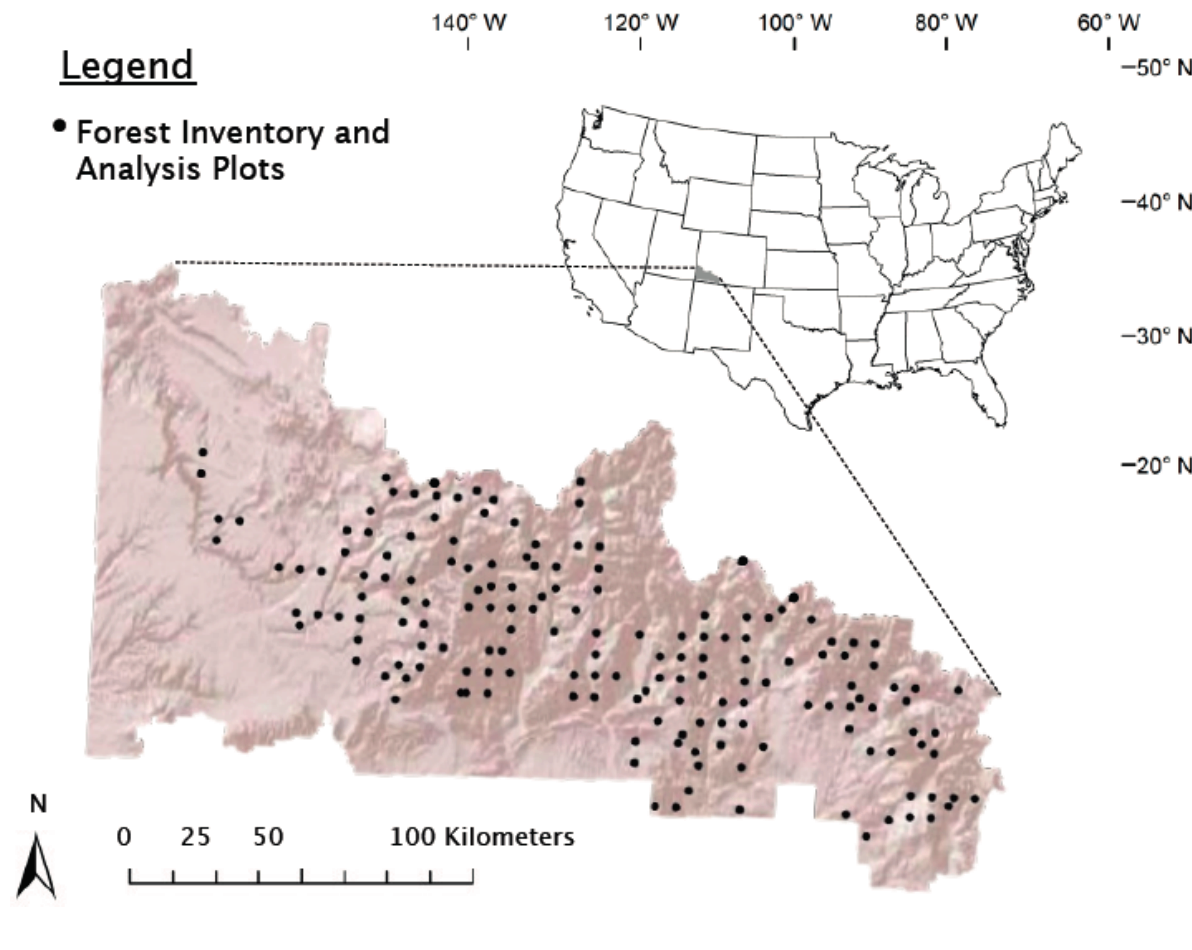
Figure 1. Location of San Juan National Forest within southwest Colorado, and distribution of Forest Inventory and Analysis plots within San Juan National Forest. Scale bar applies to regional San Juan National Forest map. Base map for San Juan National Forest extent: ESRI shaded relief imagery [17]. Projection: Albers